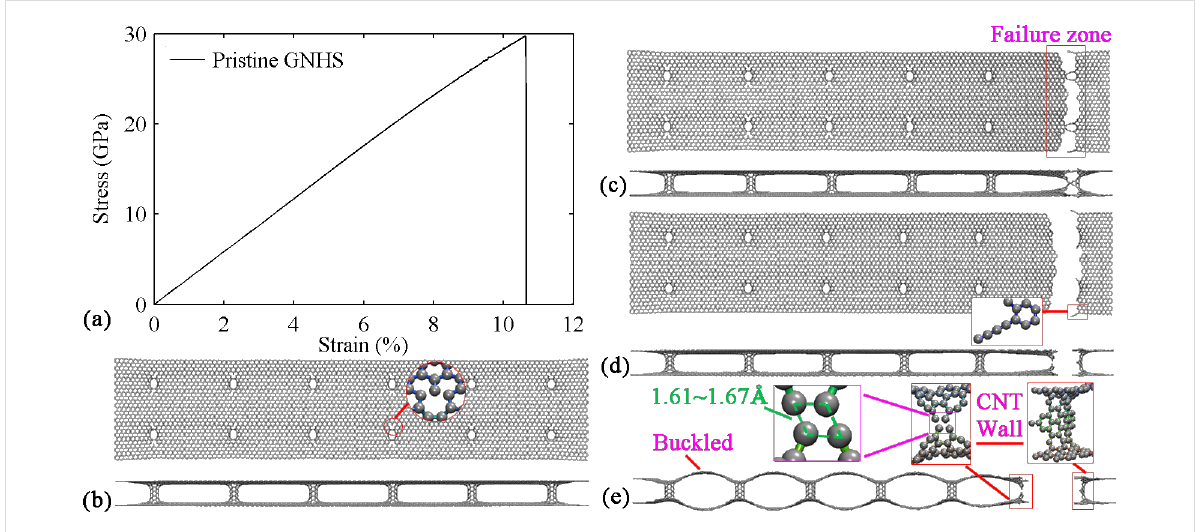
Figure 2: Simulation results for pristine GNHS: (a) Stress–strain curve; atomic configurations at the strain of (b) 0.085, inset shows the broken bonds around the connecting area; (c) 0.106; (d) 0.106, inset shows the monatomic chain; (e) 0.107.